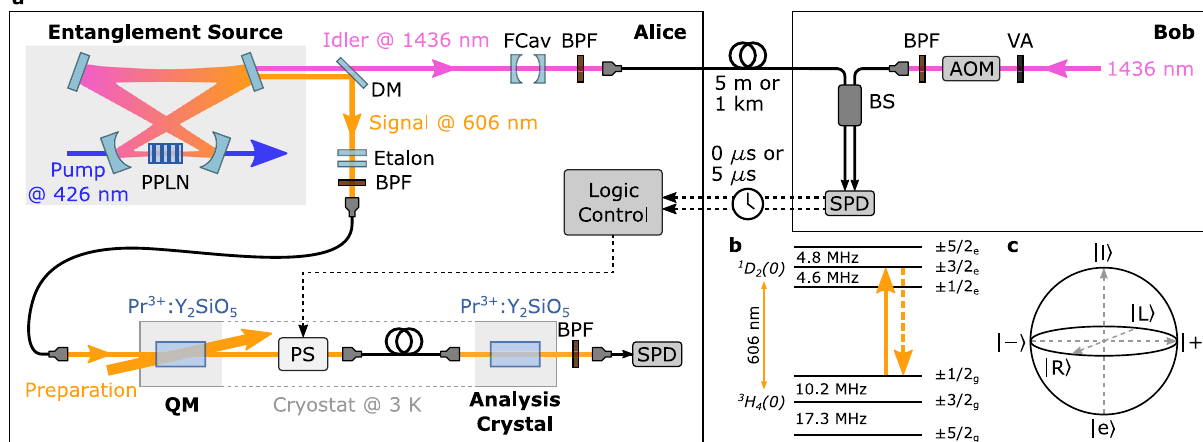
Fig. 1 | Experimental set-up. a Entangled photon pairs are generated at Alice. Signal photons are routed to a Pr-doped crystal, while the idler photons are sent towards Bob either through a 5 m or a 1 km long optical fi bre. At Bob, arbitrary qubits at 1436 nm are produced and interfered with the idler photons in order to perform a BSM. Detection results are communicated back to Alice, where they are